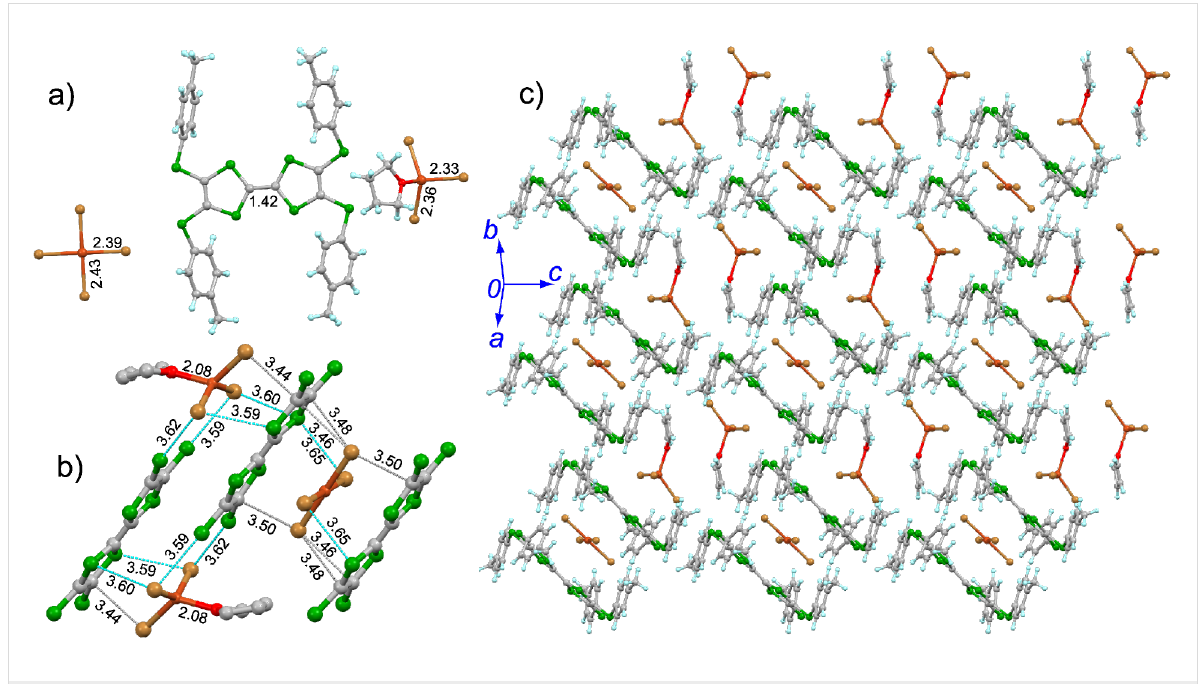
Figure 2: Crystal structure of 3 ·(CuBr 4 ) 0.5 ·CuBr 3 ·THF: a) unit cell contents with the typical bond lengths shown (Å), and the structure of planar [Cu(II)Br